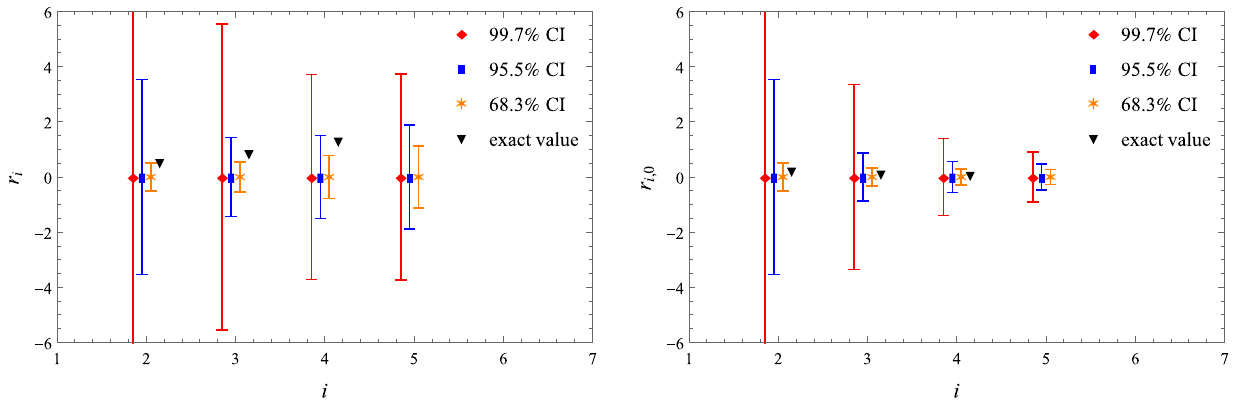
stars and the black inverted triangles together with their error bars, are for 99 . 7% CI, 95 . 5% CI, 68 . 3% CI, and the exact values of the coeffi- cients at different orders, respectively